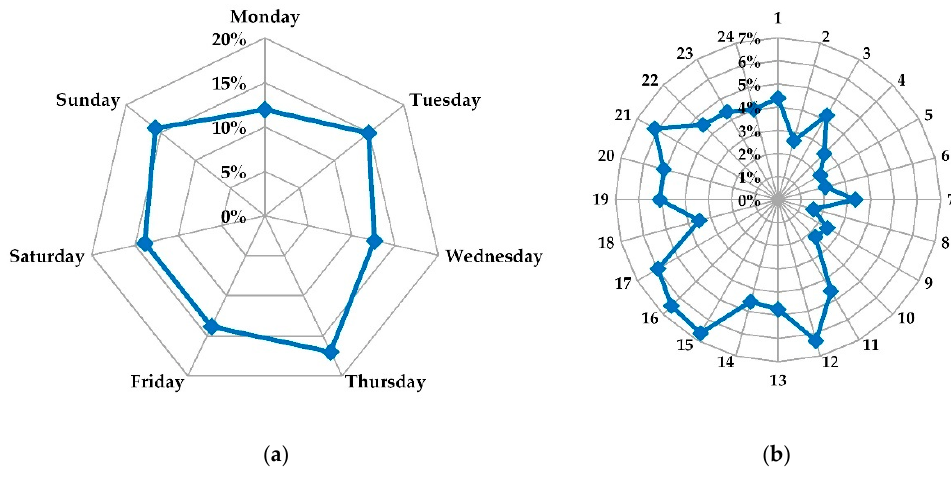
Figure 12. Temporal fire incidence pattern: ( a ) Weekdays; ( b ) Hourly.